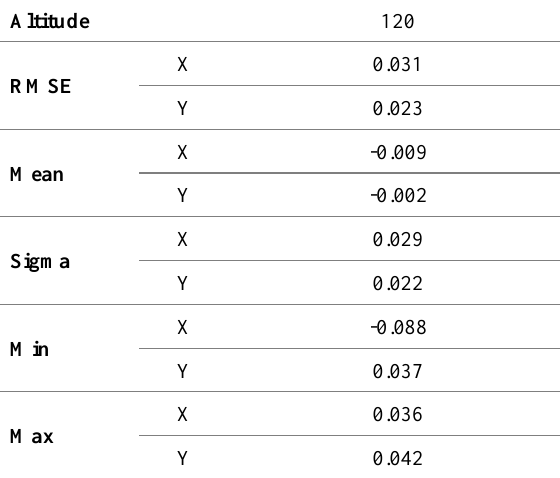
Table 4 Absolute accuracies of reference orthomosaic processed in Pix4D with ground control